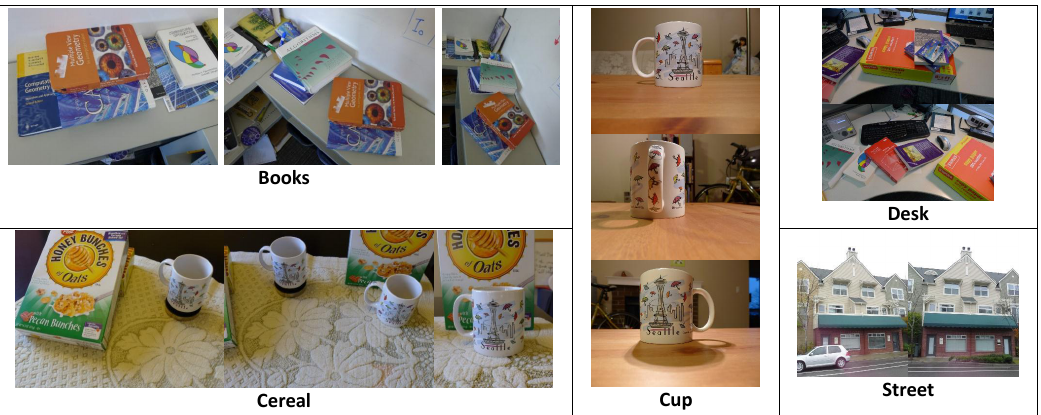
Figure 9. Sample images of five small datasets with repetitive structures.